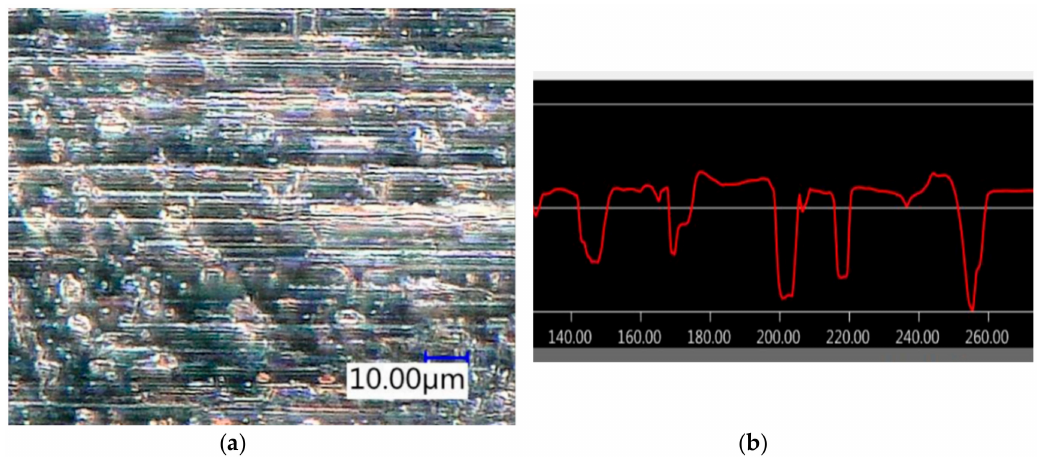
Figure 12. Microstructure ( a ) and profile ( b ) of machined surface under MQCL condition with emulsion-based nanofluid of MoS 2 0.2 wt %.